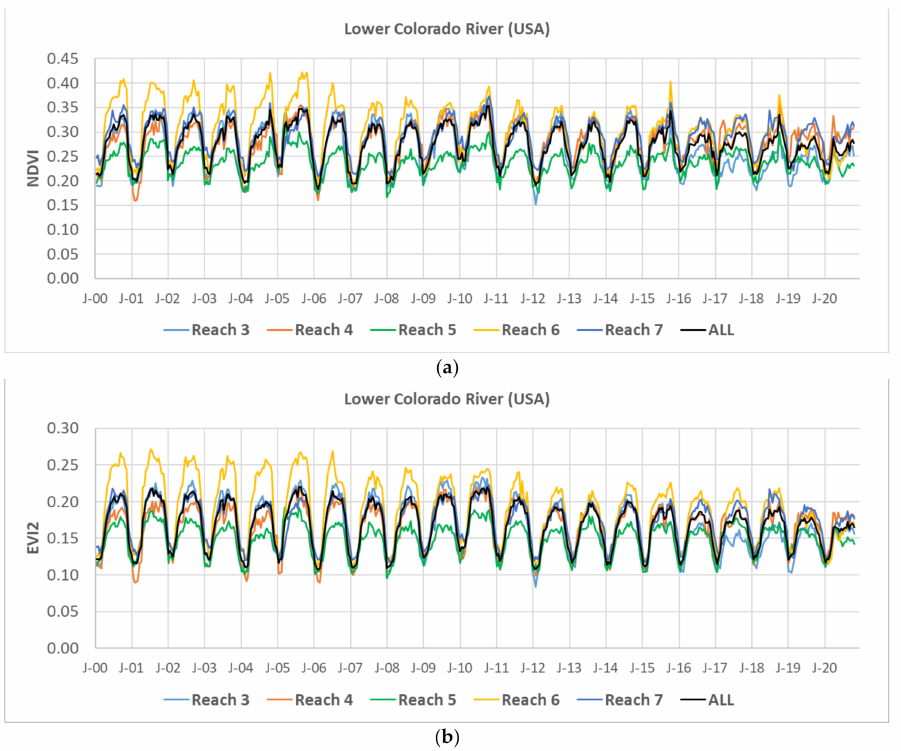
Figure 3. Time-series data from Landsat 5, 7, and 8 showing the riparian corridor of the Lower Colorado River from Hoover to Morelos dams in five reaches and the average weighted full riparian zone, All, for Normalized Difference Vegetation Index (NDVI) ( a ), and EVI2 ( b